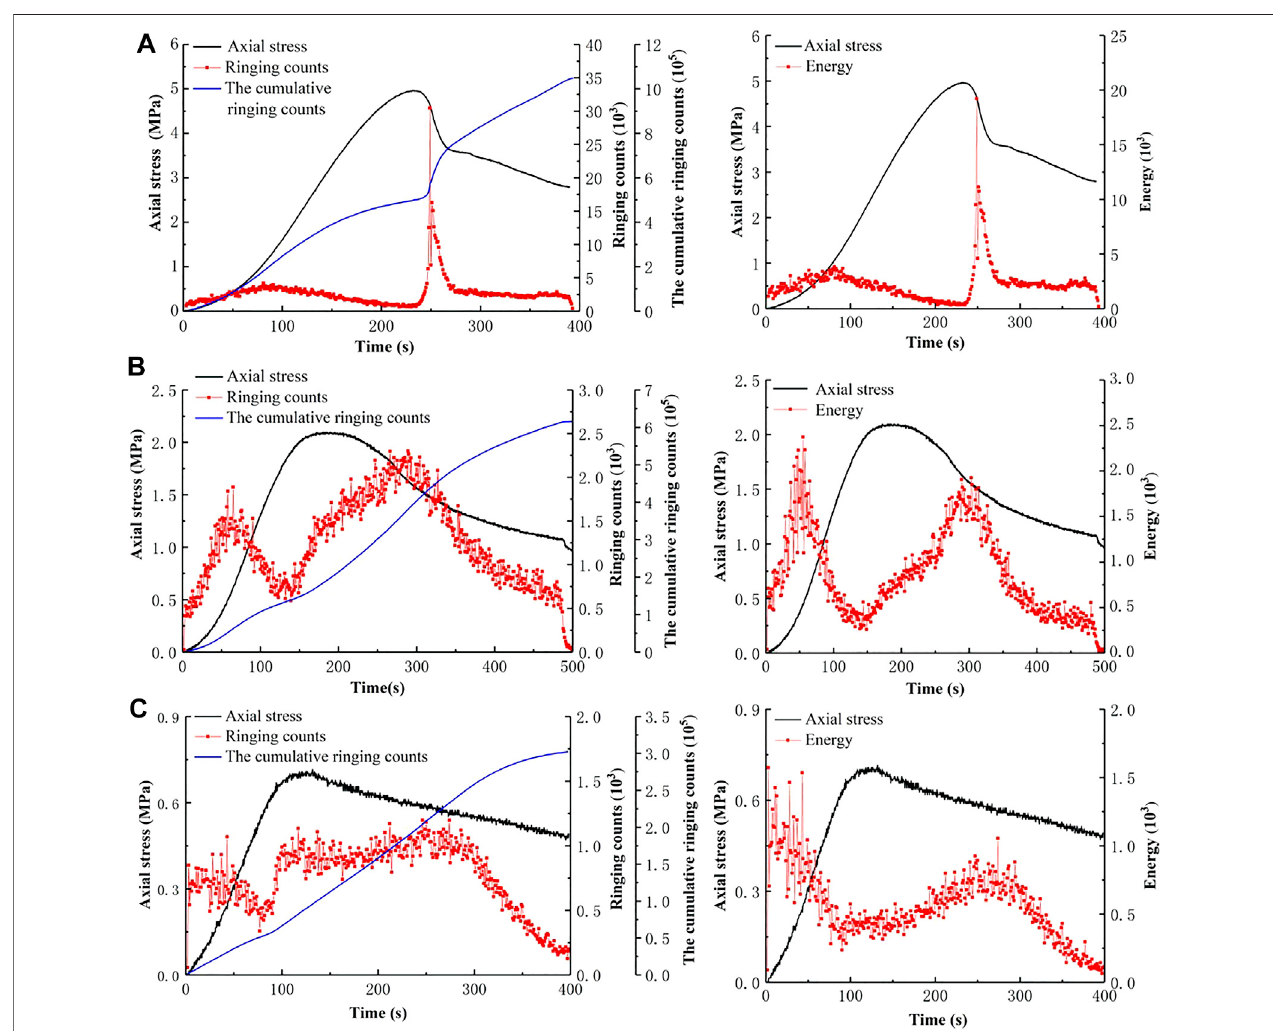
FIGURE 14 | Evolution of the AE parameters with the stress-time curves for specimens with different layer thicknesses: (A) T-0.2, (B) T-0.3, and (C) T-0.4.